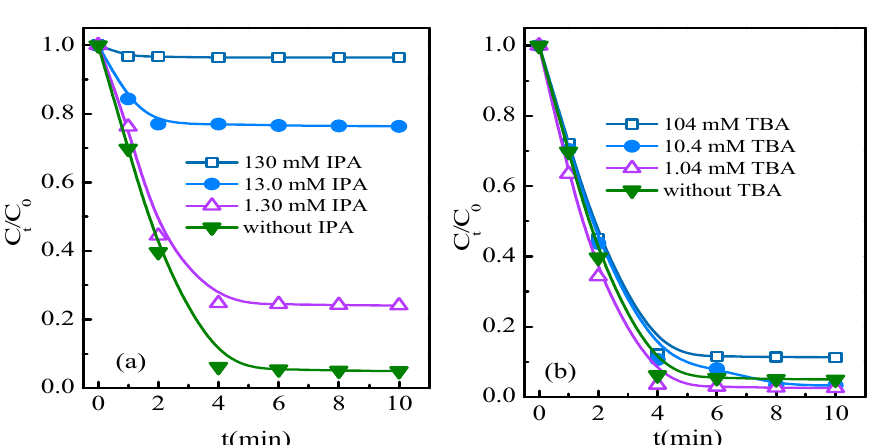
Figure 7. Signals of reactive oxidants in UVA-Fe 3+ -PMS-oxalate system under UVA irradiation and in the dark (SO 4• − and • OH under UVA irradiation ( a ) and in the dark ( d ); 1 O 2 under UVA irradiation ( b ) and in the dark ( e ); HO 2• /O 2• − under UVA irradiation ( c ) and in the dark ( f )). * signal of DMPO-OH adduct; • signal of DMPO-SO 4 adduct; ♥ signal of DMPO- 1 O 2 adduct ; ▼ signal of HO 2• /O 2• − adduct.